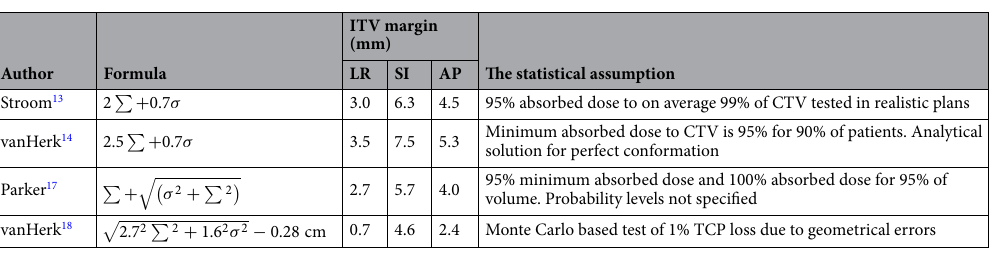
Table 2. ITV margin in three